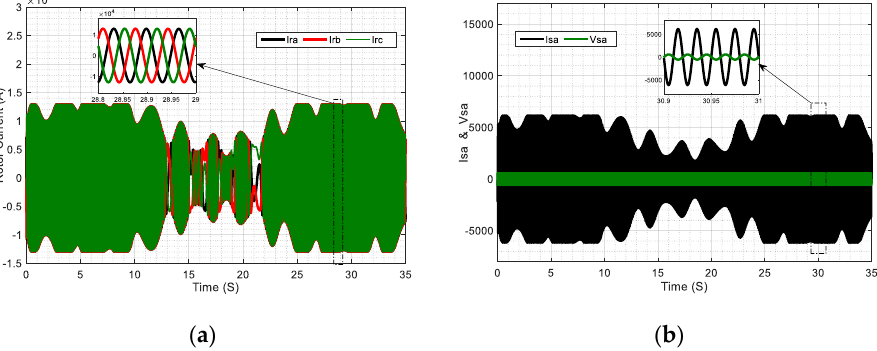
Figure 13. ( a ) Rotor currents 𝐼 𝑟𝑎 , 𝐼 𝑟𝑏 , and 𝐼 𝑟𝑐 ; ( b ) Stator currents 𝐼 𝑠𝑎 and stator voltage 𝑉 𝑠𝑎 .